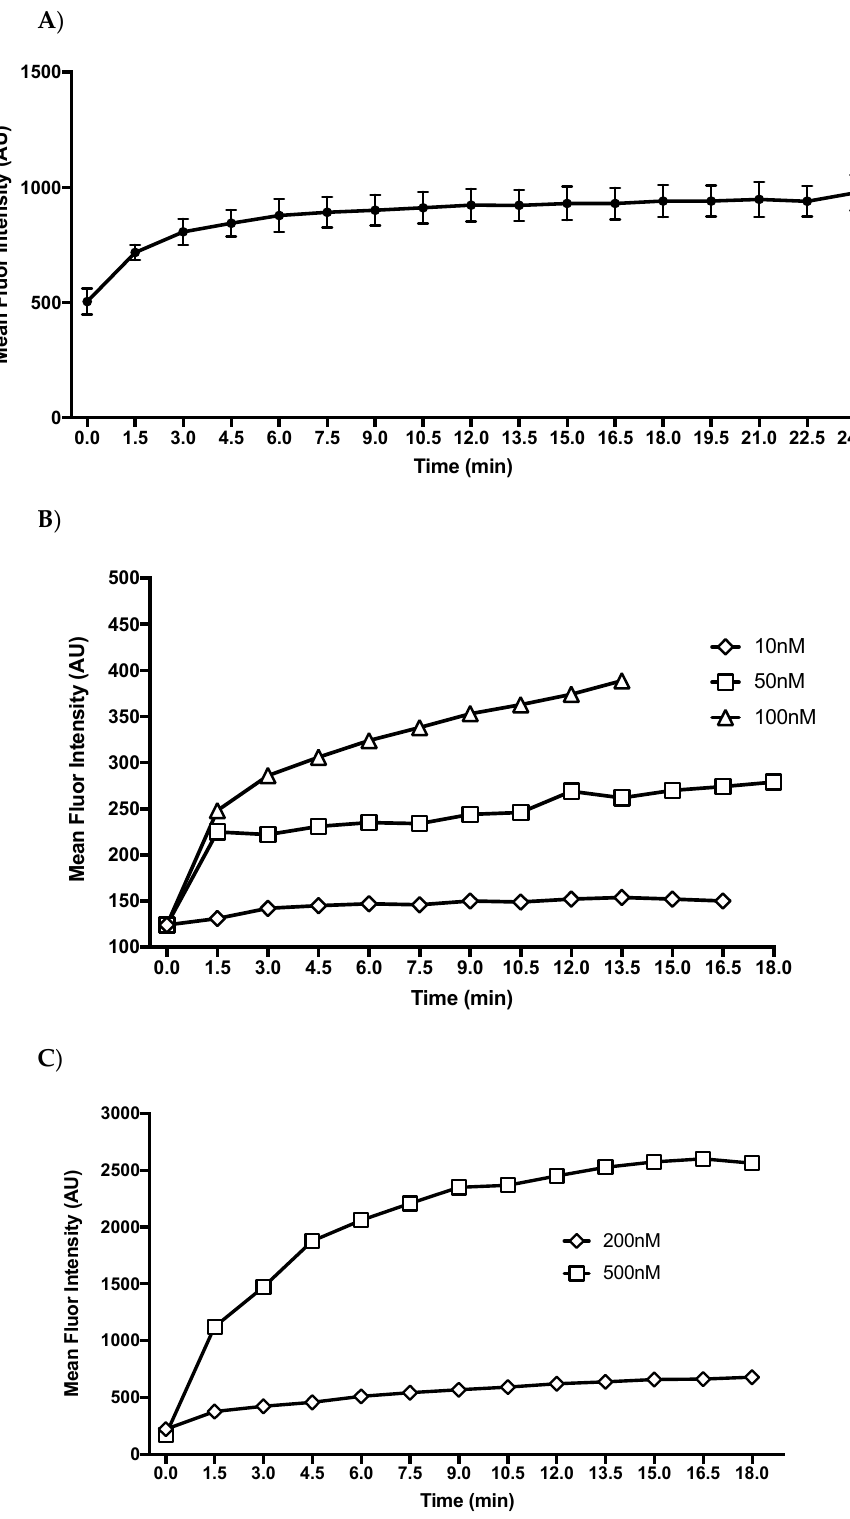
Figure 3. Uptake rate of fluorescent labeled T1AM (FL-T1AM). 3T3-L1 cells were given FL-T1AM and their mean shift in fluorescent intensity was measured with 10,000 cells per time point. T1AM uptake appears to involve a three-phase pattern, consisting of a rapid exponential uptake, followed by a linear steady increase, and ending with a plateau. ( A ) Mean fluorescent shift of FL-T1AM signal at 100 nM ± SEM. ( B ) Fluorescent signal intensity over time at 10, 50, and 100 nM. ( C ) Fluorescent signal intensity over time at 200 nM and 500